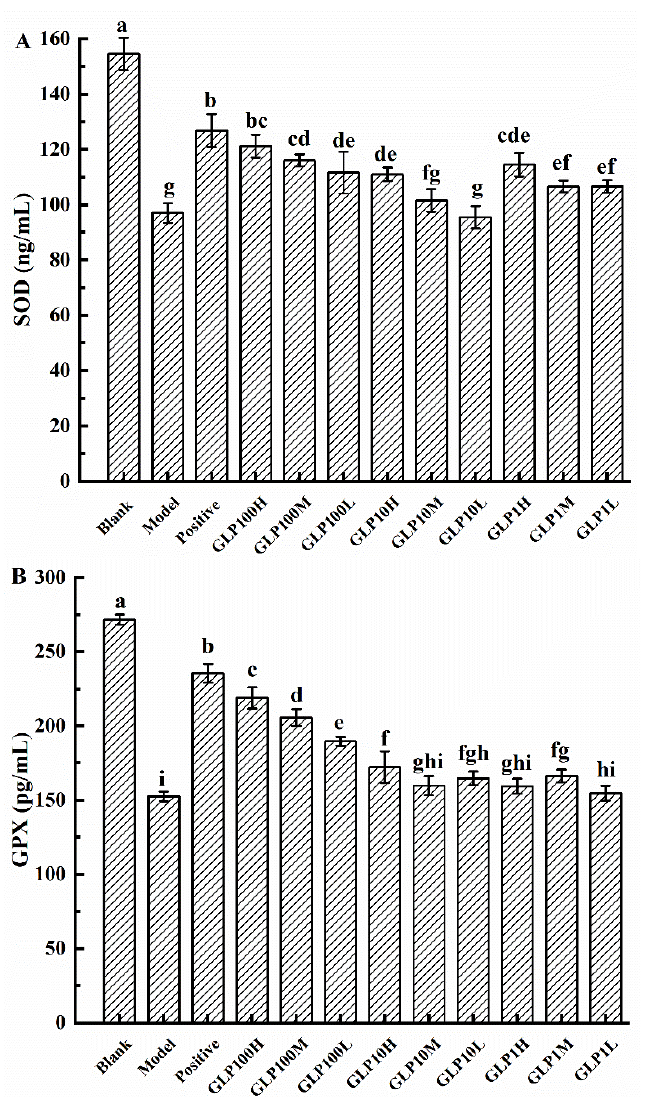
Figure 3. Effects of GLPs on SOD ( A ) and GPX ( B ) activities in rats. Different lowercase letters (a – i) indicate significant differences at p < 0.05.